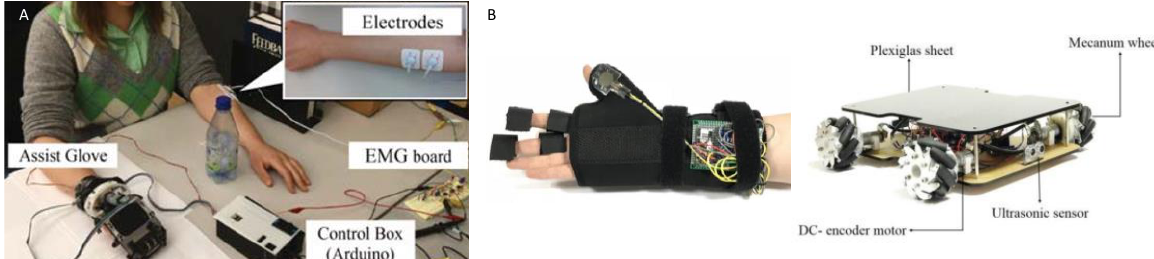
Figure 36. Soft glove control solutions. ( A ) Hybrid control method for a Semi-soft Assistive Glove (SAG) [93]. Reprinted/adapted with permission from Ref. [93]. 2019, IEEE. ( B ) Control of mobile four wheels robots through a soft glove [96]. Reprinted/adapted with permission from Ref. [96]. 2018,